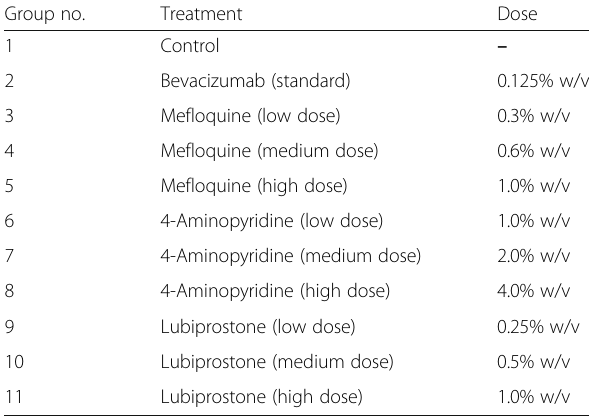
Table 1 Treatment schedule for corneal neovascularization method Group